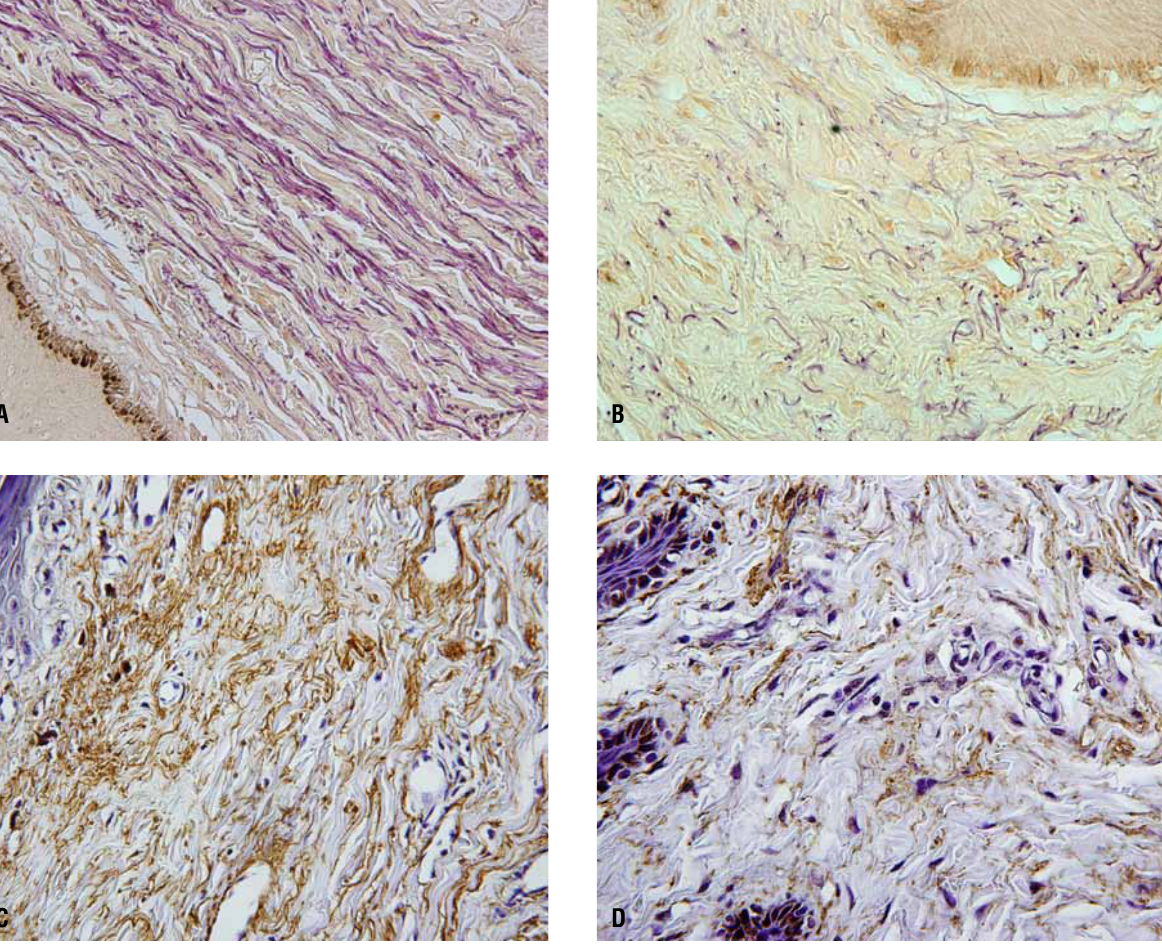
Figure 2 - Foreskin elastic system fibers. A) 28 years old smoker. Weigert x400. B) 28-years old non-smoker. Weigert x400. Note the marked increase of elastic fibers (brown) in the smokers compared to non-smokers. c) Immunohistochemistry with anti-elastin in the foreskin of 32 years old smoker patient showing elastic fibers (brown). Anti-elastin antibody